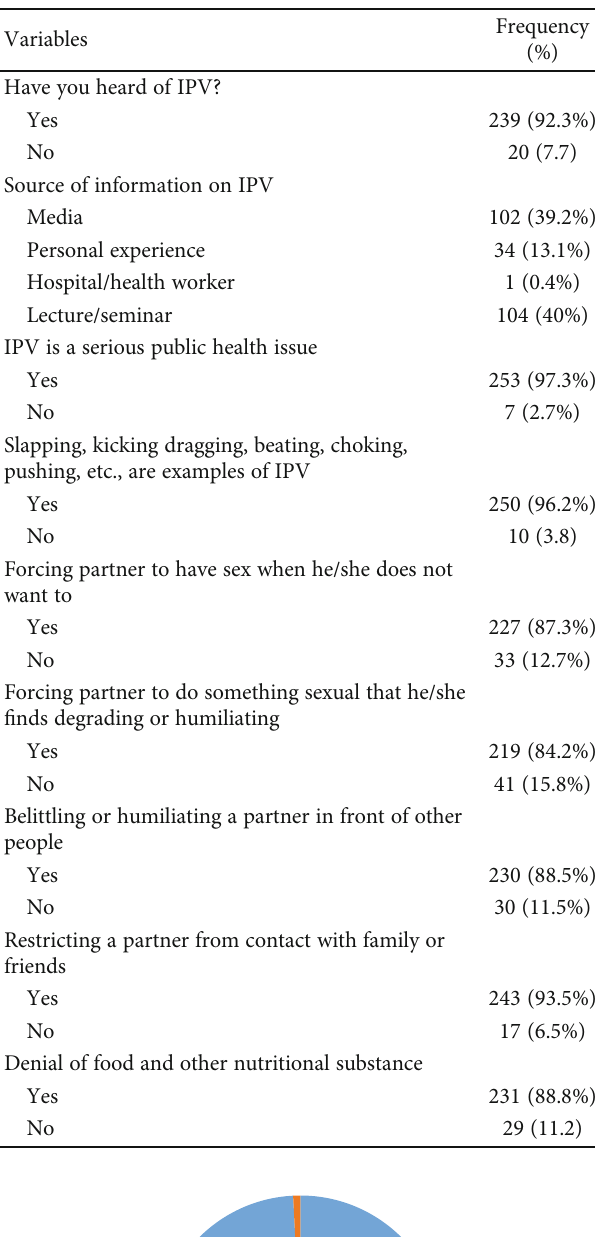
Table 2: Knowledge of IPV among pregnant women.